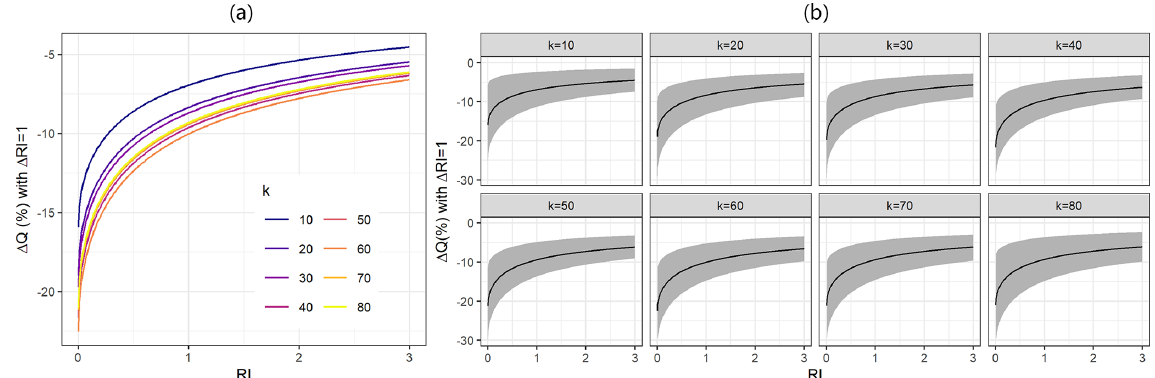
Figure 5. (a) Percentage change in annual maximum discharge ( Q ) caused by a 1 unit increase in reservoir index (RI) from different initial RI values based on different numbers of catchment groups ( k ). (b) The same as (a) but with the 95% confidence intervals shown by shaded areas.